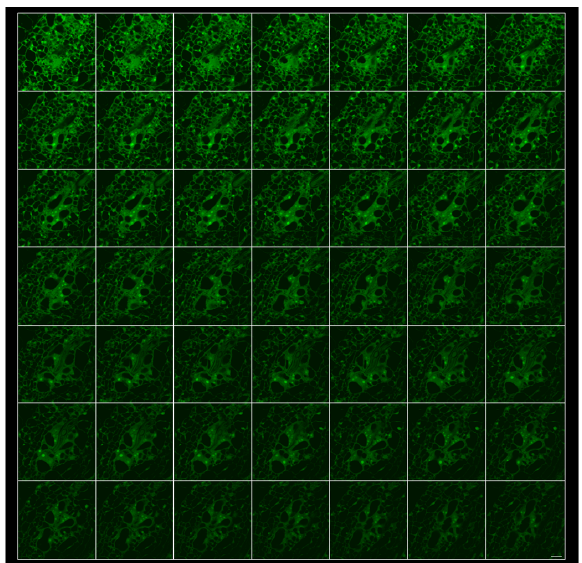
Figure 1. The fixation and clearing method allows the complete sectioning of a gall induced by Meloidogyne javanica in Arabidopsis thaliana roots at 48–72 h post infection; montage of 49 1- μ m optical sections. The images were taken from entire galls after fixation with glutaraldehyde and clearing with BABB. Scale bar: 20 μ m. Confocal parameters: PMT 1 (Offs.): − 5.70. PMT 1 (HV): 418.22. Excitation beam splitter FW RSP 500. λ ex/ λ em 480 nm/500–600 nm. Pinhole (Airy) 1.00.